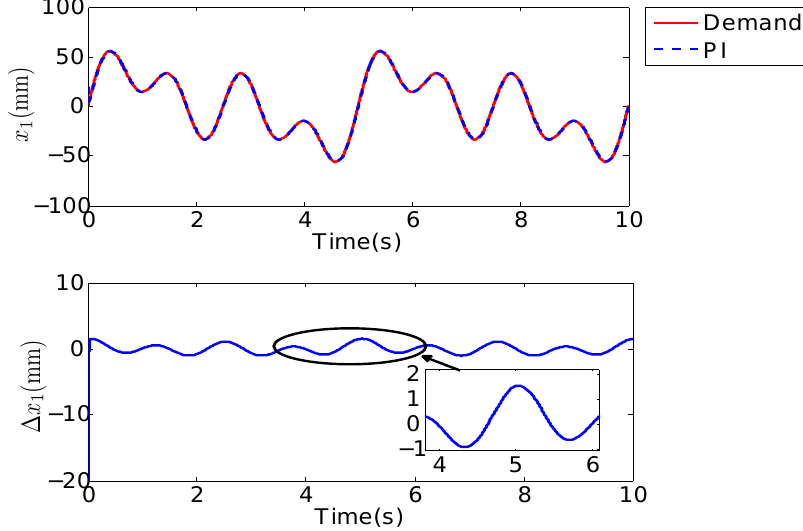
Figure 5. The cylinder position responses x 1 by PI controller with ∆ 2 = ∆ 3 = 0, the demand y d = 25 ( sin ( 1.6 π t ) + sin ( 0.8 π t ) + sin ( 0.4 π t ))